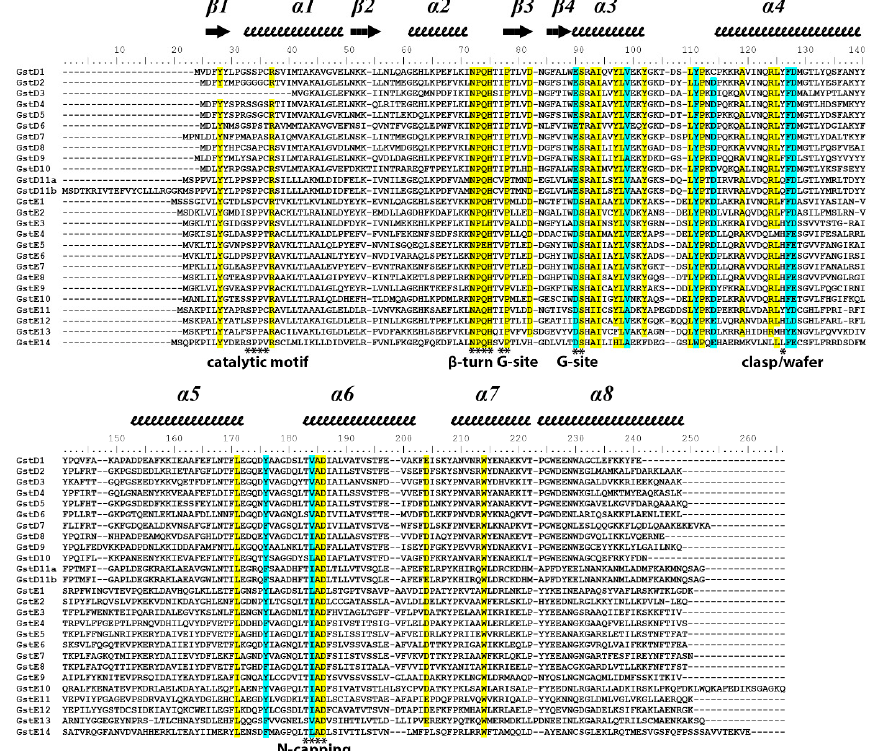
Figure 1. Sequence alignment of Delta and Epsilon GSTs from Drosophila melanogaster . Secondary structures have been inferred from the X-ray structure of DmGSTD2 (5F0G, [28]) and reported above the alignment. Conserved sites are annotated below the alignment with a star indicating the involved amino acids.